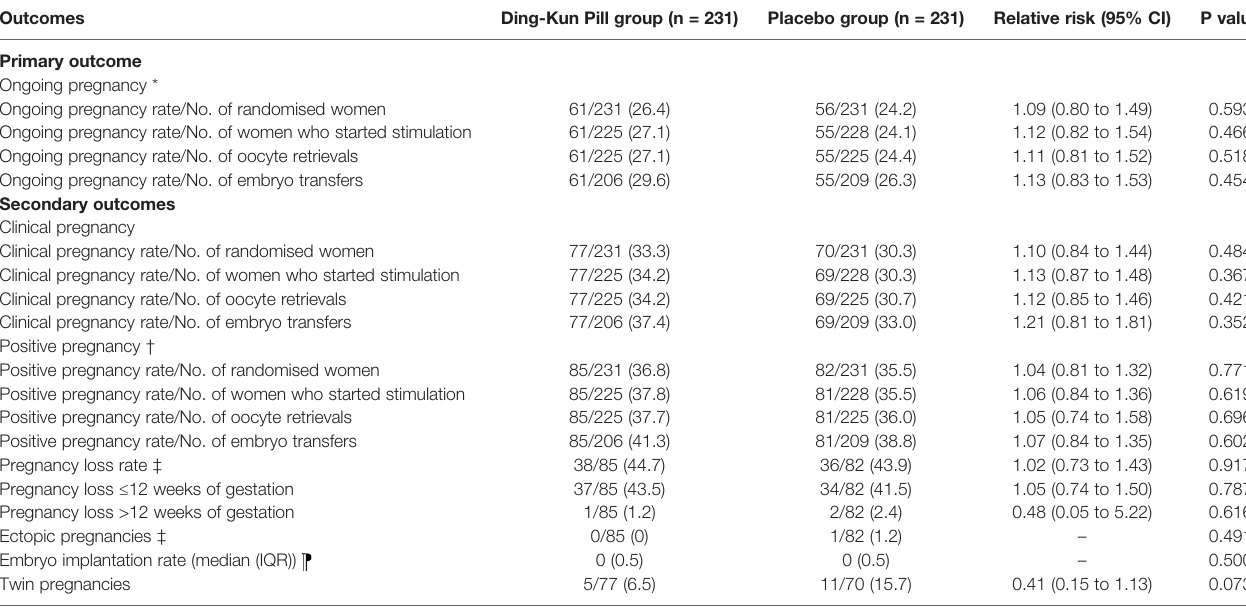
TABLE 3 | Reproductive outcomes for women in Ding-Kun Pill and placebo groups (intention-to-treat analysis). Outcomes Ding-Kun Pill group (n = 231) Placebo group (n = 231) Relative risk (95% CI) Primary outcome Ongoing pregnancy * Ongoing pregnancy rate/No. of randomised